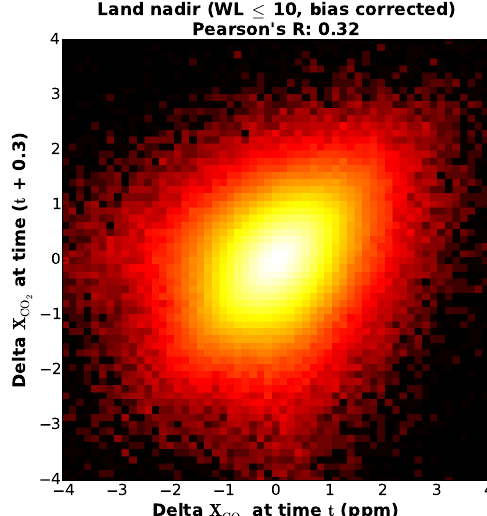
Figure 4. Distribution of XCO 2 values between time steps for the set of observations from each “small neighborhood” used in this